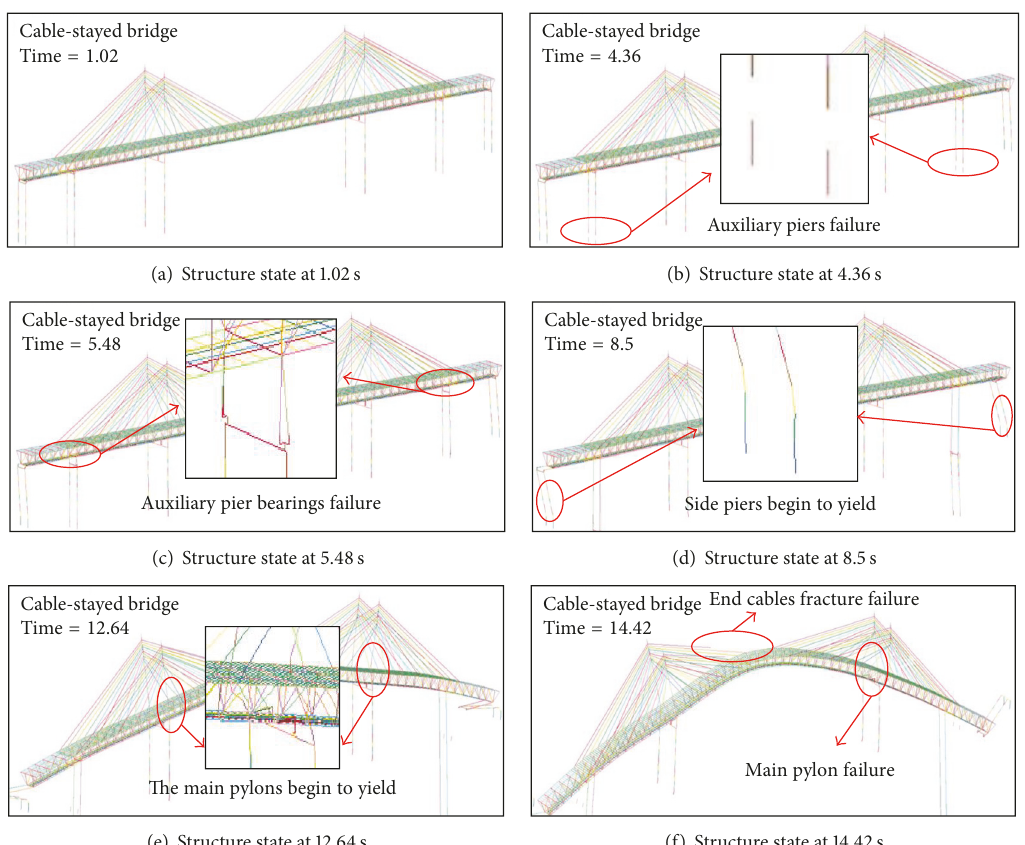
Figure 9: Collapse failure process under RSN6-H1 seismic